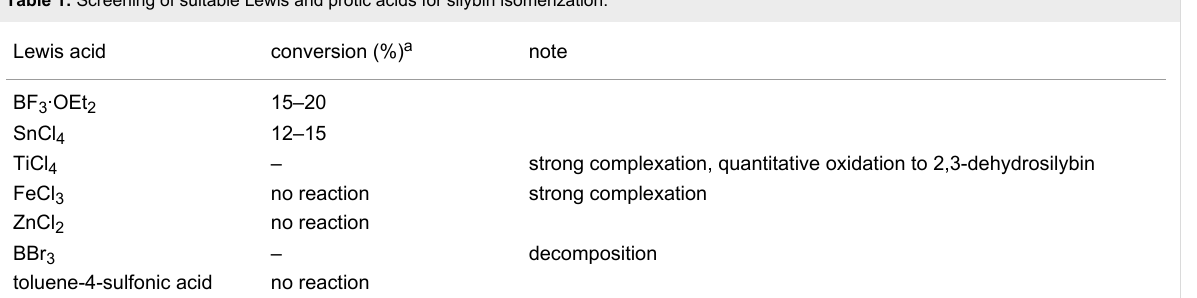
Table 1: Screening of suitable Lewis and protic acids for silybin